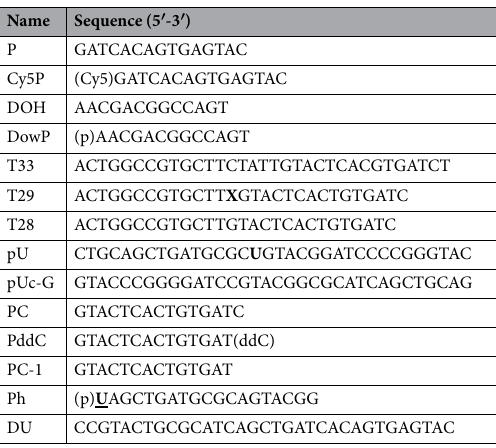
Table 1), on 5-nt gapped molecules (obtained by hybridization of oligonucleotides Cy5P, T33 and either DOH or DowP, which contains a 5 ′ -phosphate) and on 1-nt gapped molecules (obtained by hybridization of oligonu- cleotides Cy5P, T29X and DowP). The incubation mixture (12.5 μ l) contained 50 mM Tris-HCl pH 7.5, 1.25 mM